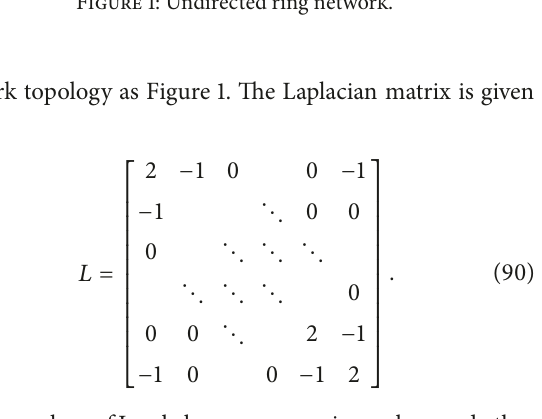
Figure 1: Undirected ring network.